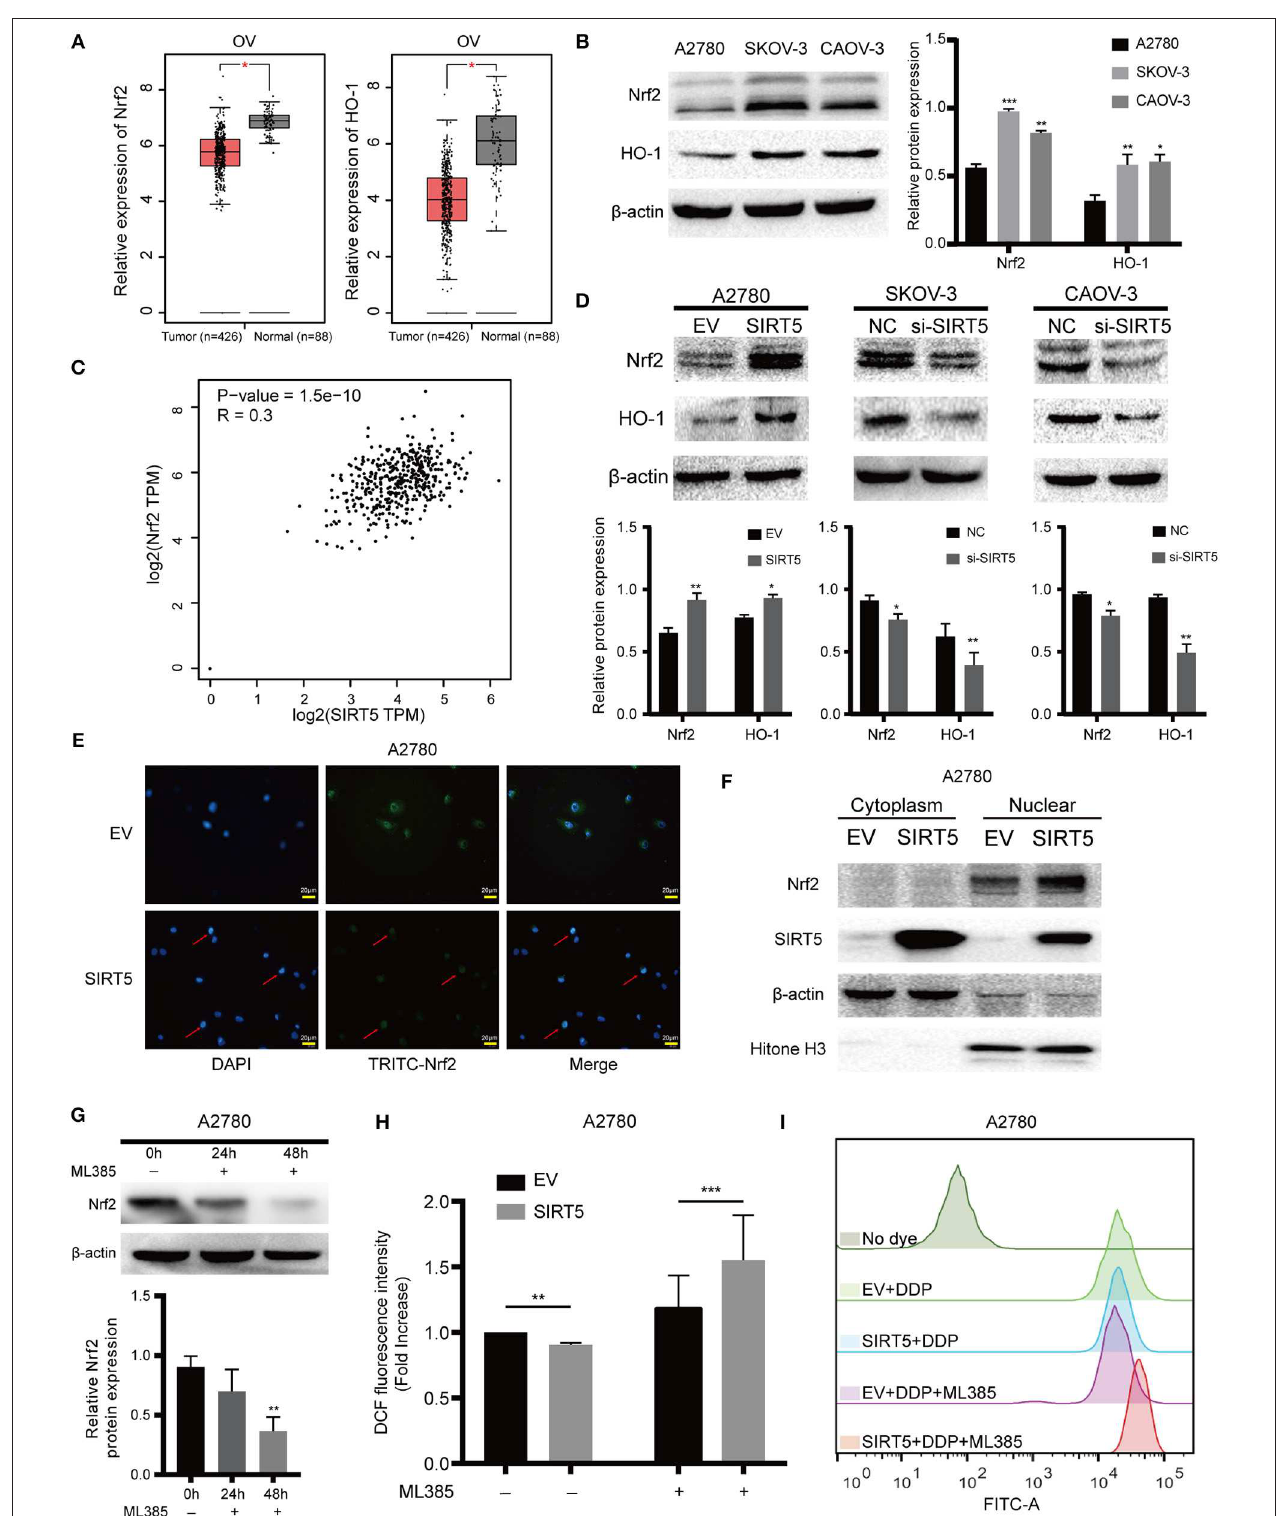
FIGURE 6 | SIRT5 inhibits ROS via positively regulating Nrf2/HO-1 pathway. (A) The mRNA expression of Nrf2 and HO-1 in ovarian cancer and normal tissues (GEPIA). (B) Nrf2 and HO-1 protein levels were higher in SKOV-3 and CAOV-3 than A2780 cells assessed by western blot and the relative gray values were shown in histogram. (C) The correlation between Nrf2 and SIRT5 in ovarian cancer based on GEPIA database by Pearson correlation coefficient. (D) Overexpression of SIRT5